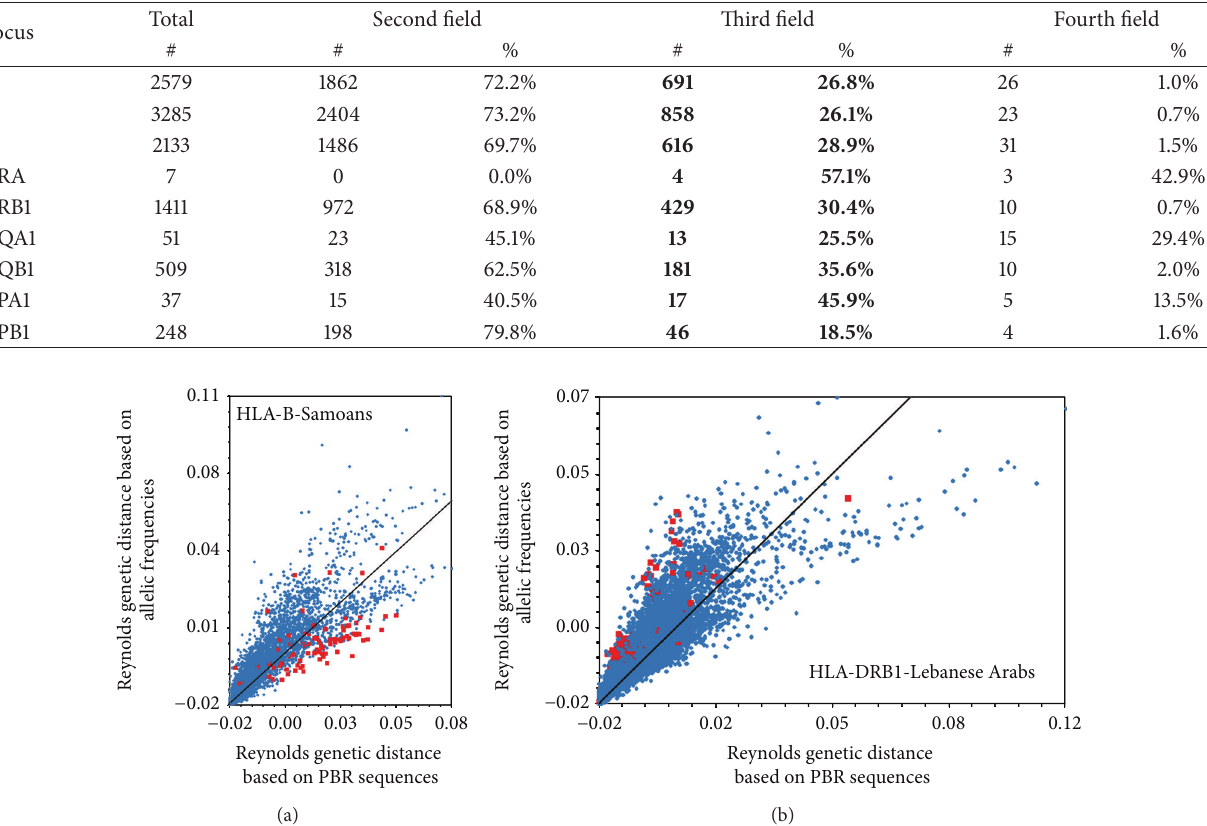
Figure 1: Plot comparisons of two different measures of genetic distances among populations. Each point corresponds to a pair of populations (taken from a large database of 90 populations typed for HLA -B and 106 populations typed for HLA -DRB1, resp.) for which two values are reported: the genetic distance estimated by taking into account both the allele frequencies and the molecular distance between the alleles -derived” Reynold’s genetic distance based on PBR sequences, 𝑋 axis) and the genetic distance estimated only from allele frequencies (“ Φ st -derived” Reynolds’ genetic distance based on allele frequencies, 𝑌 axis). (a) Locus HLA -B; in this plot, the population pairs formed by the (“ 𝐹 st Samoans and all other populations are highlighted by red squares. (b) HLA -DRB1; in this plot, the population pairs formed by the Lebanese Arabs and all other populations are highlighted by red squares. For Samoans at HLA -B, genetic distances are clearly skewed toward higher values with Reynold’s genetic distance based on PBR sequences, while the opposite situation is observed for the Lebanese Arabs at HLA -DRB1. Taking into account the molecular information has thus substantial effects on the estimation of population relationships (from